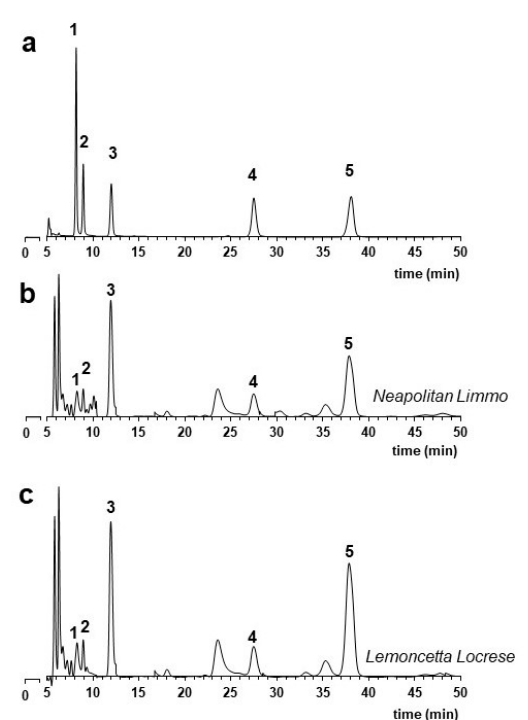
Figure 3. Organic acid profile of Neapolitan limmo and lemoncetta locrese. ( a ) Standard containing a mixture of tartaric acid (1) 0.5 mg / mL; quinic acid (2) 0.5 g / L; malic acid (3) 0.5 g / L; citric acid (4) 0.5 g / L; fumaric acid (5) 2.5 mg / L. ( b ) LC chromatograms of Neapolitan limmo ( c ) LC chromatograms of lemoncetta Locrese.